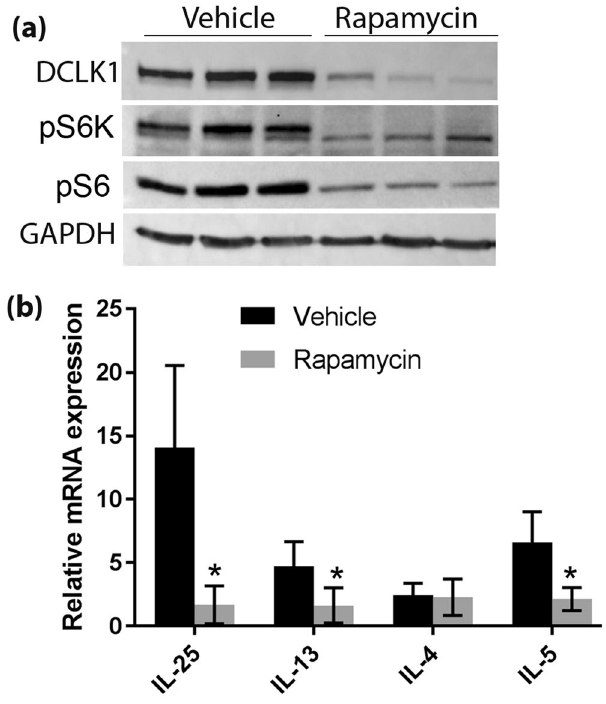
Figure 2. Systemic mTORC1 inhibition diminishes tuft cells. Vilin-Cre ER ( + / − ); Raptor (f/f) mice were randomized into 2 groups (n = 5 for Vehicle and n = 6 for Rapamycin) and injected intraperitoneally with either vehicle (5% Tween-80, 5% PEG-400 in PBS) or Rapamycin (4 mg/kg body weight) for 8 days before sacrifice. ( a ) Representative Western blot analysis of the protein expression in enterocytes as indicated. GAPDH was used as a loading control. ( b ) Real-time PCR quantification of IL-25 expression in enterocytes and IL-13/IL-4/IL-5 expression in lamina